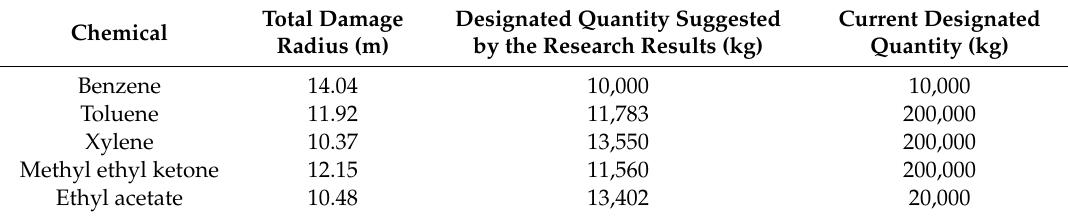
Table 7. Feasibility evaluation of specified quantities for each chemical.